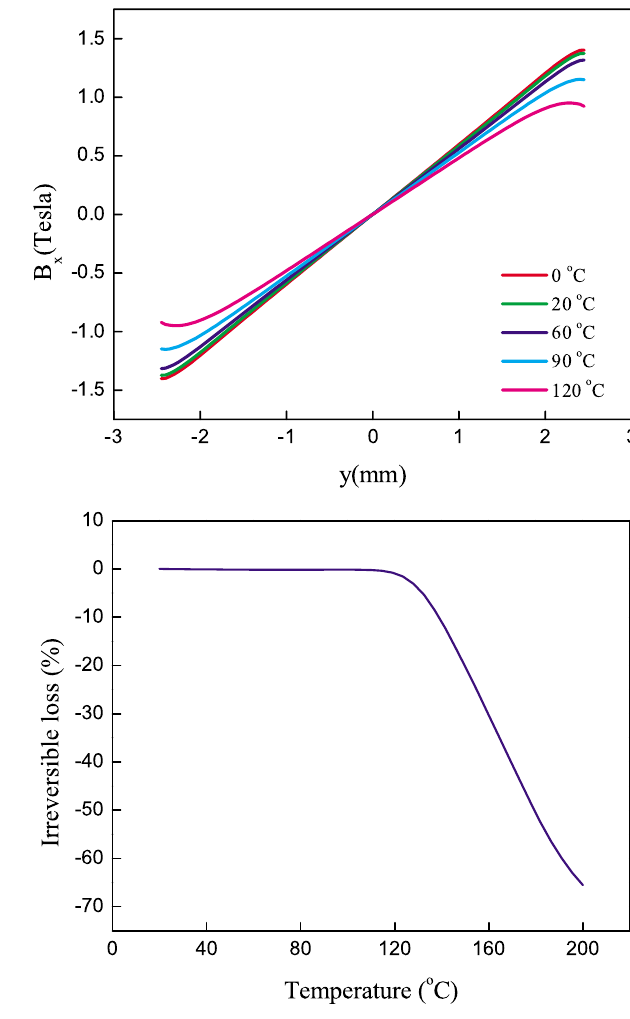
FIG. 3. (Color) Magnetic field spatial dependence showing de- crease in slope as temperature value increases (top); percentage loss of field gradient as a function of temperature (bottom).